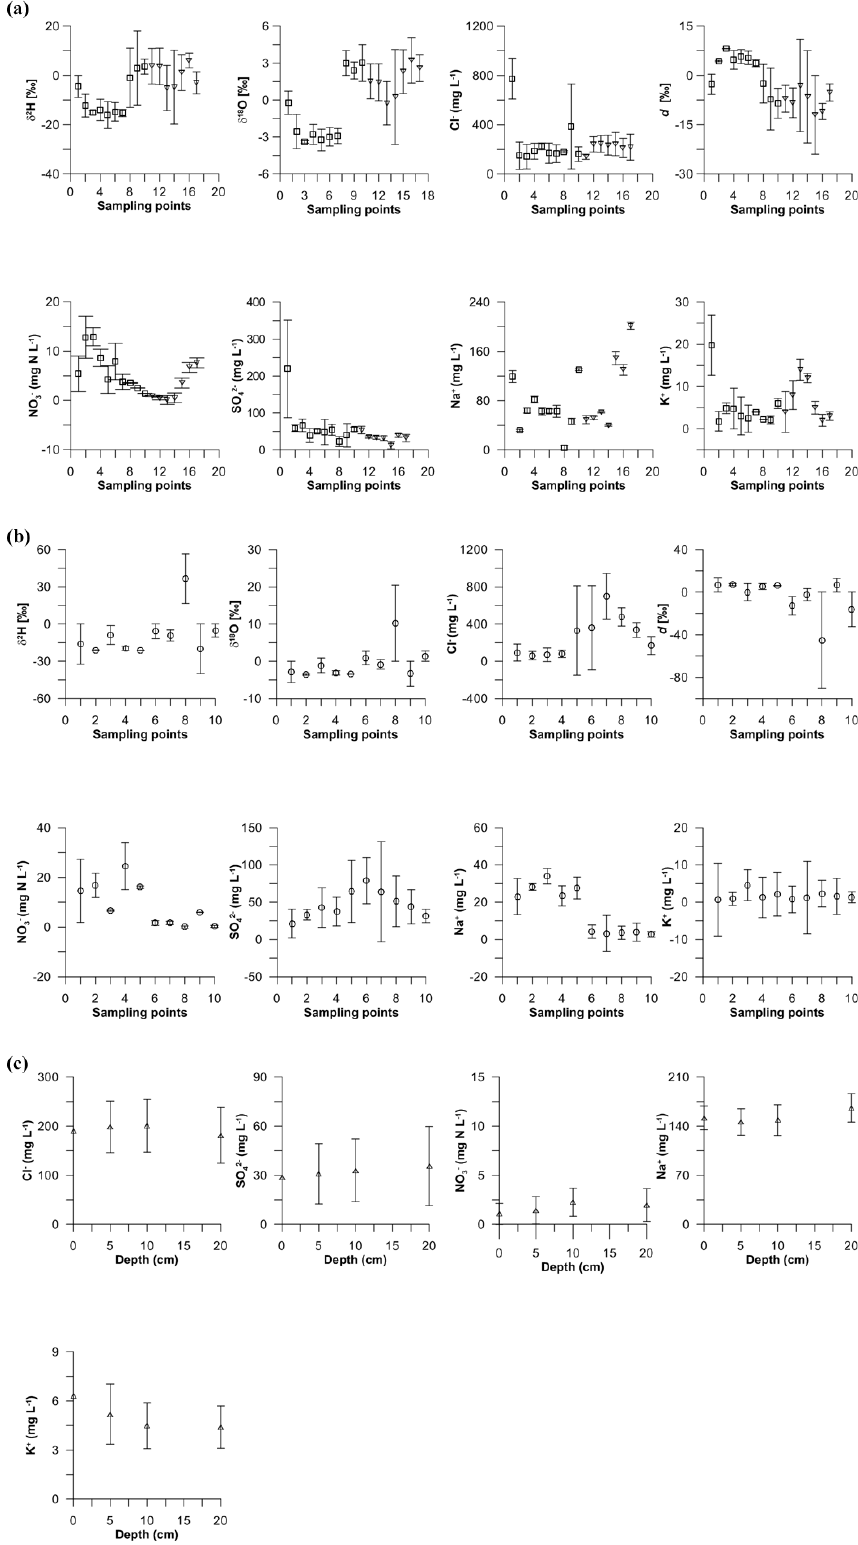
Fig. 5. Chemical composition of δ 2 H, δ 18 O, Cl − , SO 2 − the reservoir, inverted triangles indicate the reservoir to Victoria river), (b) shallow groundwater and (c) pore water during the three periods. Sampling points (A1 to A17) are numbered from 1 to 17 in the